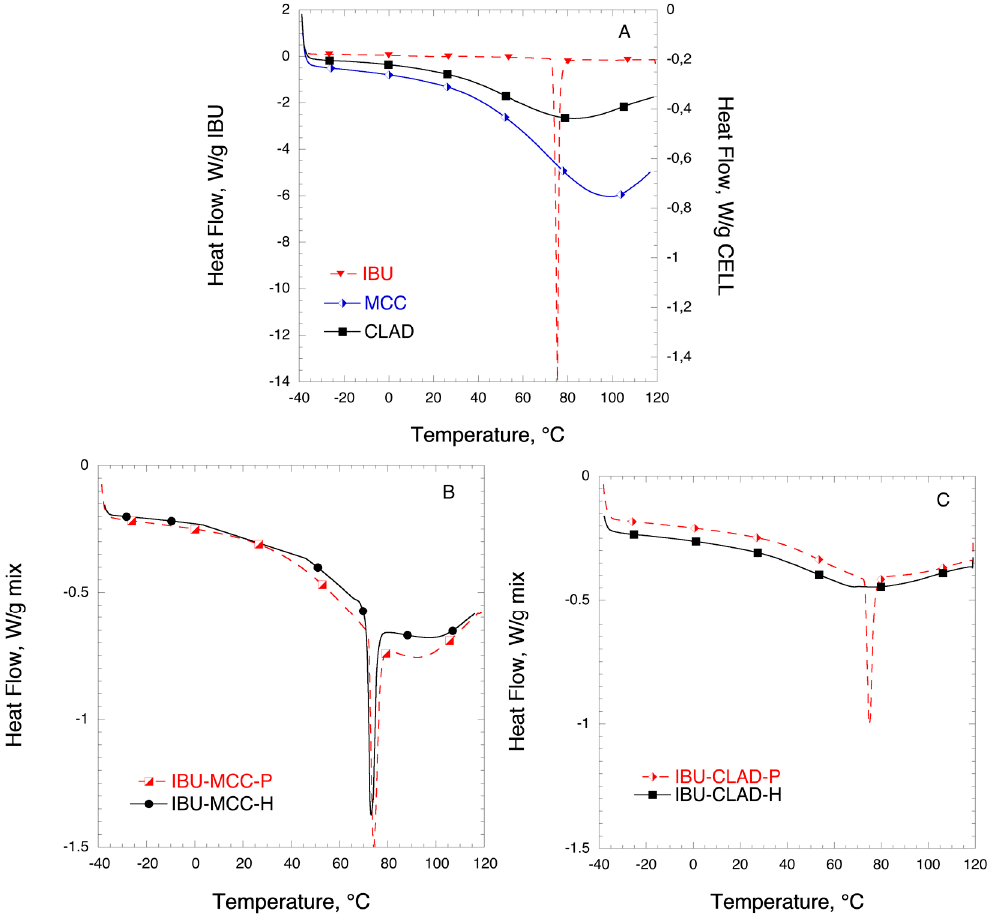
Figure 3. Differential scanning calorimetry (DSC) analysis of ( A ) pure IBU, MCC, and CLAD, ( B ) IBU-MCC, and ( C ) IBU-CLAD 10% w / w mixtures. The symbols are only a guide for the eye.